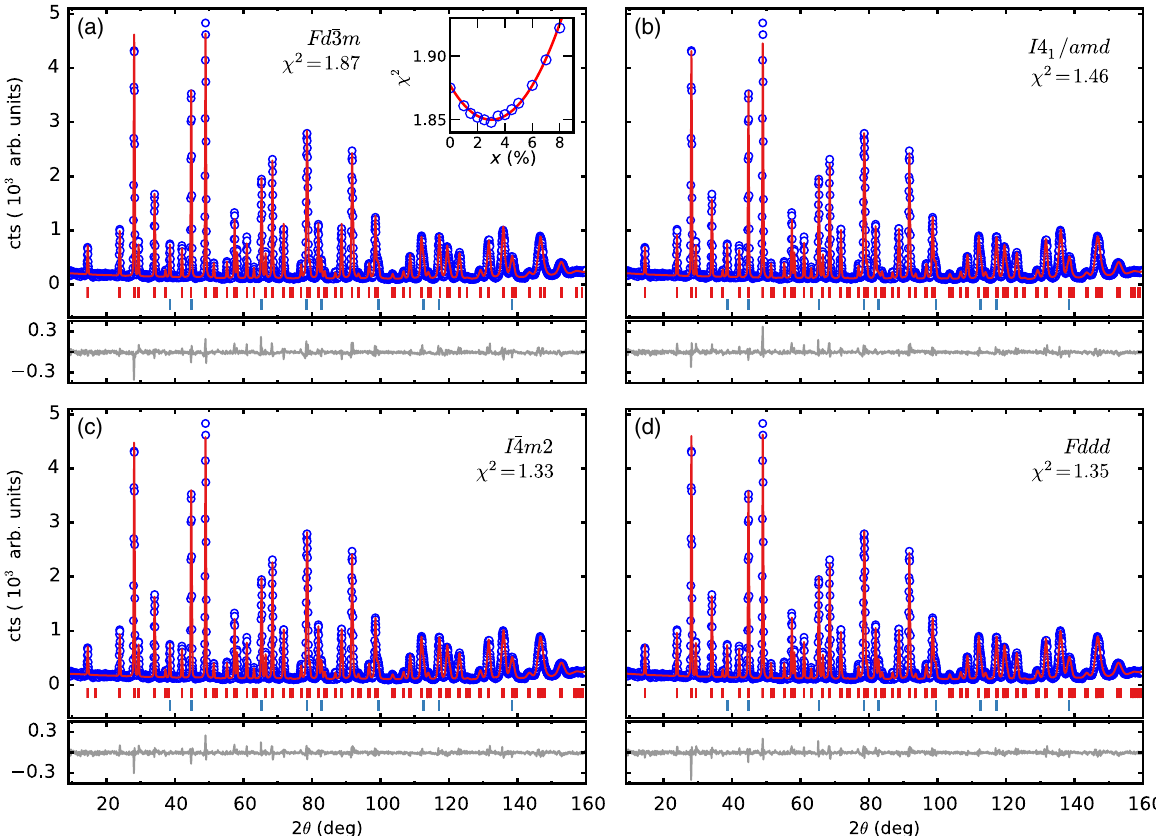
FIG. 10. Structural models for FeSc 2 S 4 . (a) – (d) Rietveld analysis of neutron powder diffraction measured on BT-1 at 20 K. Blue circles are measured data, red line is the calculated diffraction pattern, and red vertical bars indicate the positions of nuclear reflections in the respective space group. Contributions from the aluminum sample environment are indicated by blue vertical bars. The difference between calculated and measured data is shown in the lower panel for (a) – (d). Inset in (a) shows the goodness-of-fit parameter ( χ 2 ) versus the Fe-Sc antisite inversion in the cubic model.